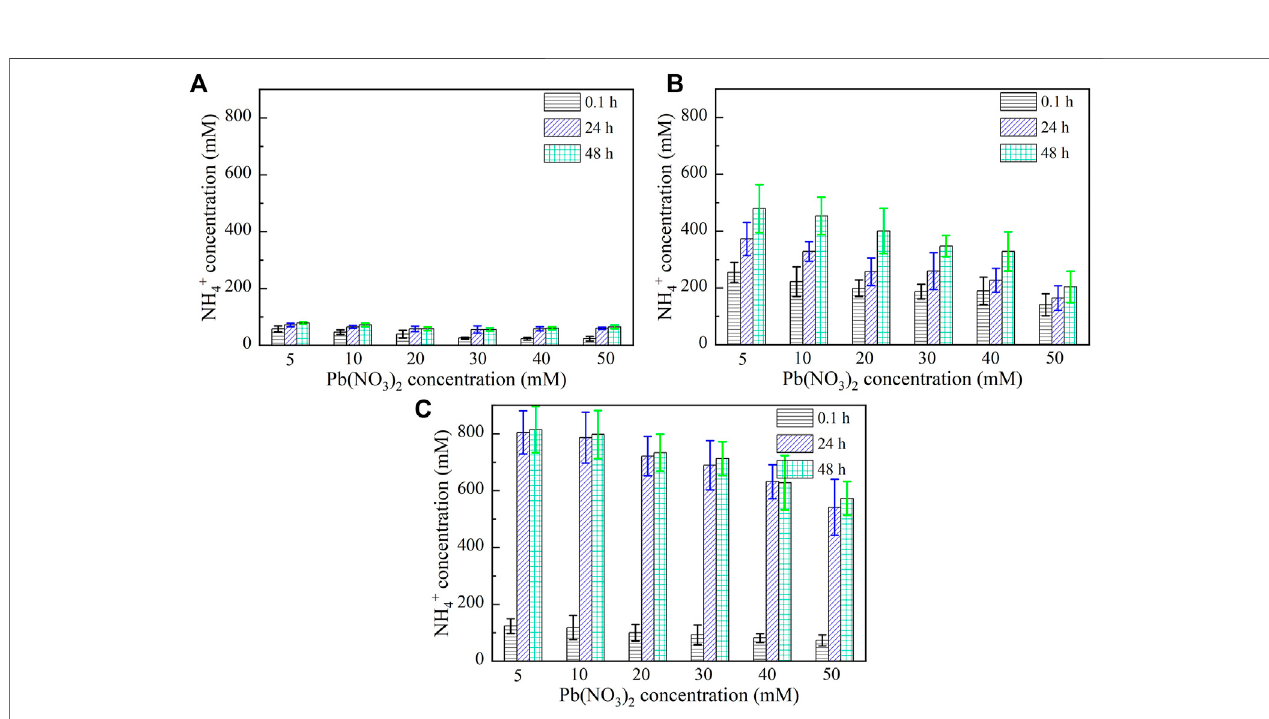
FIGURE5| RelationshipsofNH 4+ concentrationversusPb(NO 3 ) 2 concentration: (A) withoutyeastextract and CaCl 2 , (B) underthe effect ofyeastextract,and (C) under the effect of yeast extract and CaCl 2 addition.